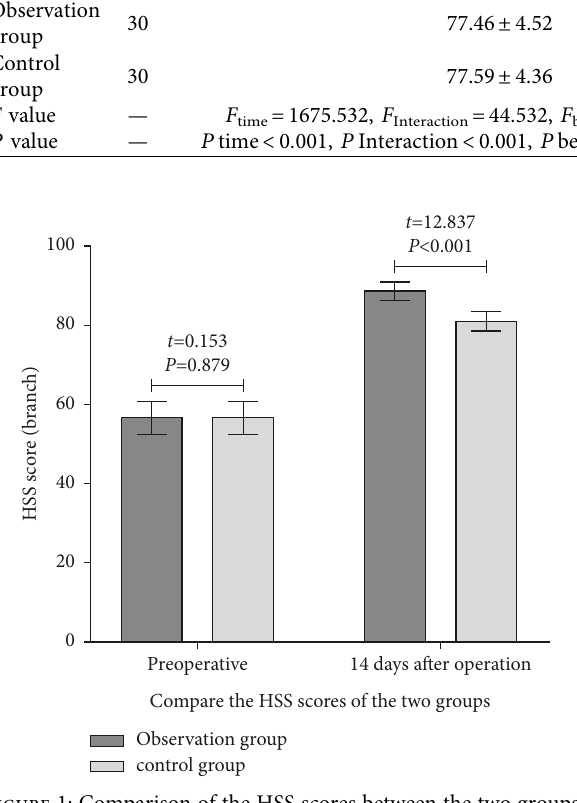
Figure 1: Comparison of the HSS scores between the two groups.